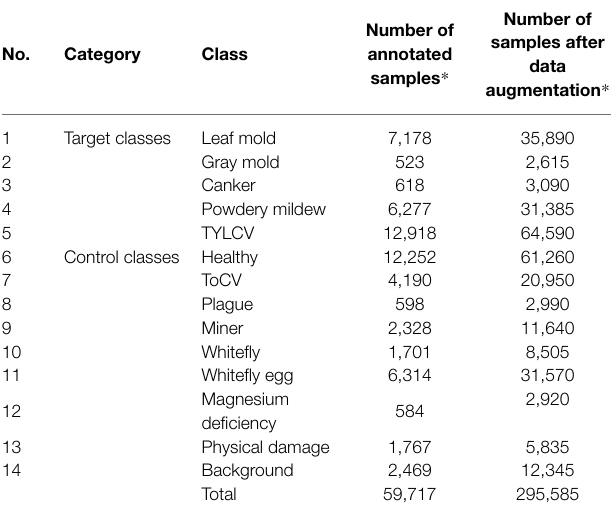
TABLE 1 | Training/validation dataset of tomato plant diseases with target and control classes.